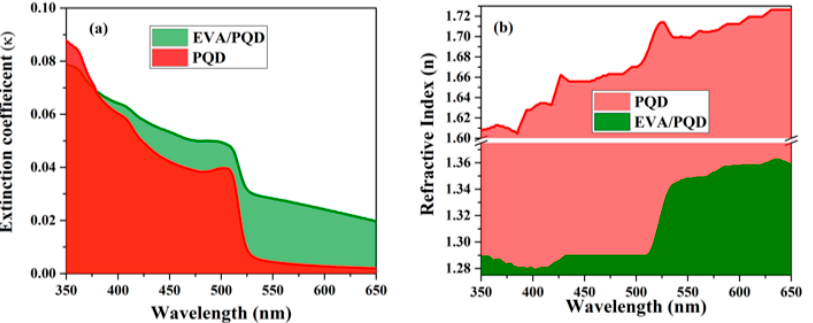
Figure 7. Computed ( a ) extinction coefficients k( λ ) and ( b ) refractive indices n( λ ) of the pure PQD and the EVA-TPR/PQD films.